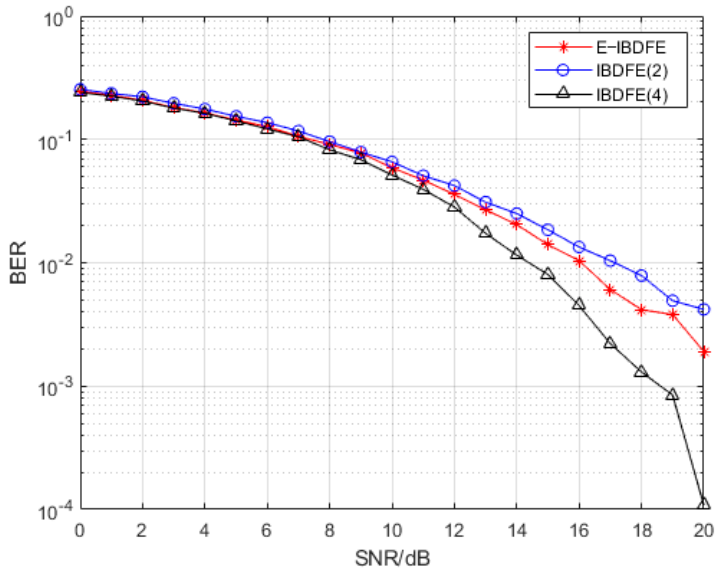
Figure 6. Comparison of BER of E − IBDFE and IBDFE in EVA channel.